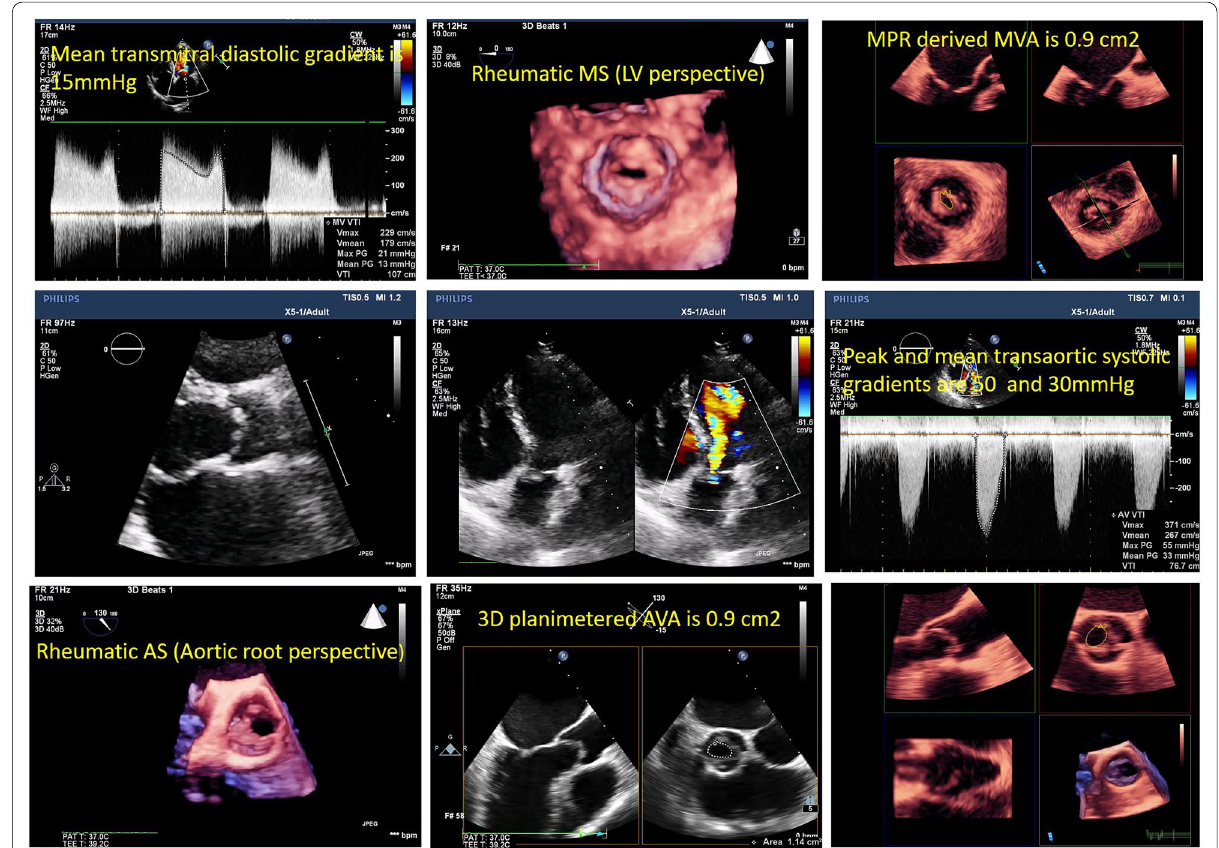
Fig. 9 A case of rheumatic mitral and aortic valve diseases. In the upper panel, severe mitral valve stenosis was found; mean diastolic gradient 15 mmHg .3D zoomed volume shows the characteristic "en‑face" view of the thickened leaflets and commissural fusion. MVA was = traced using MPR as 0.9 cm2. In the middle panel, a 2D parasternal long‑axis view of the aortic valve shows systolic doming of the cusps. The apical 5‑chamber view shows aortic valve regurgitation. In the lower panel, 3D‑zoomed volume of the aortic valve shows thickened cusps and fused commissure between right and non‑coronary cusps. X‑plane mode and MPR‑derived AVA are 0.9